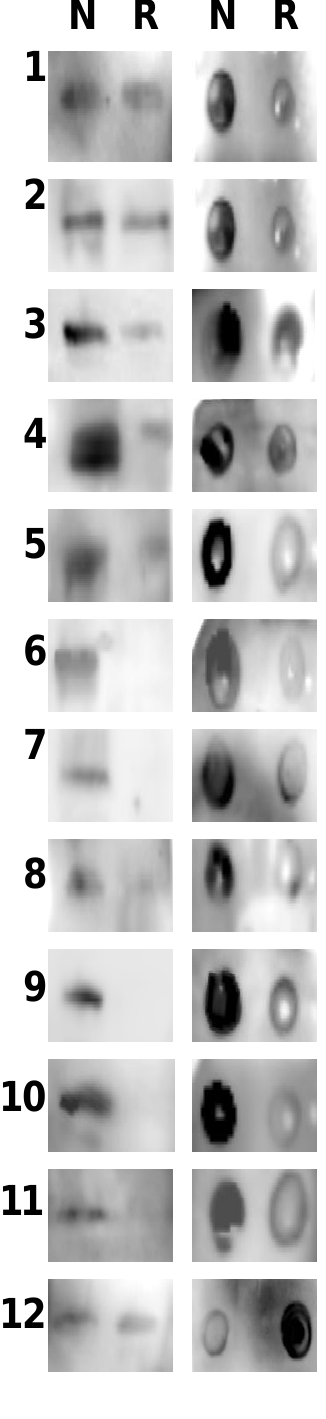
Figure 8. IgE western blot and spot blot comparison of natural and recombinant Ara h 1. Natural (N) and rAra h 1 (R) were subjected to western blot (left panels) or spot blot (right panels) with sera from 12 peanut allergic individuals (1 and